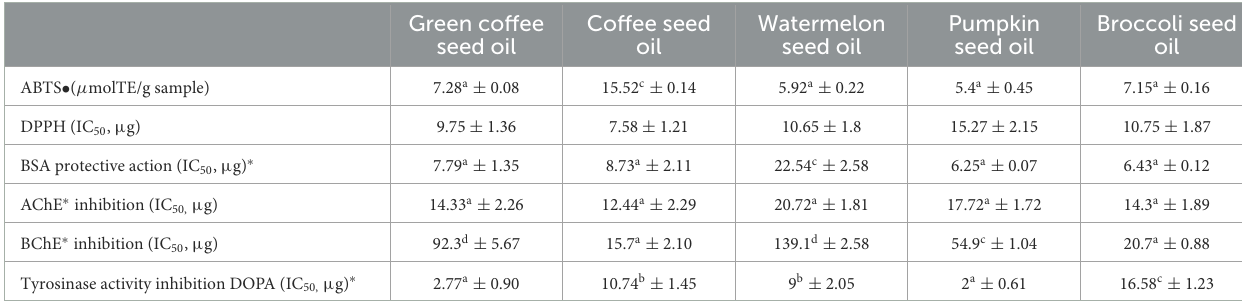
TABLE 2 Antioxidant activity (evaluated through ABTS and DPPH tests), protective effect against the bovine serum albumin degradation, and cholinesterases (AChE and BChE) and tyrosinase inhibitory activities exhibited by the five seed